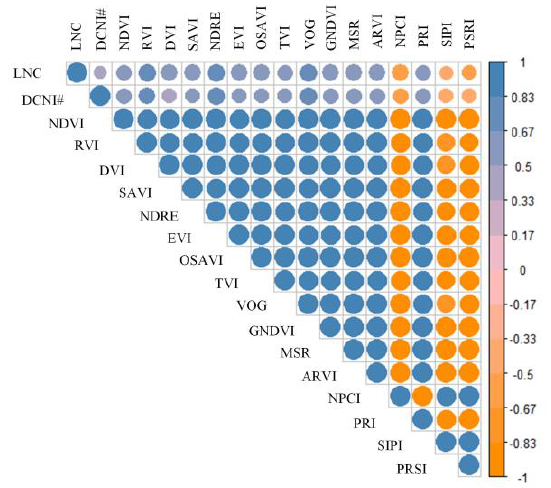
Figure 5. Matrix diagram of the correlation coefficient between VIs and LNC.